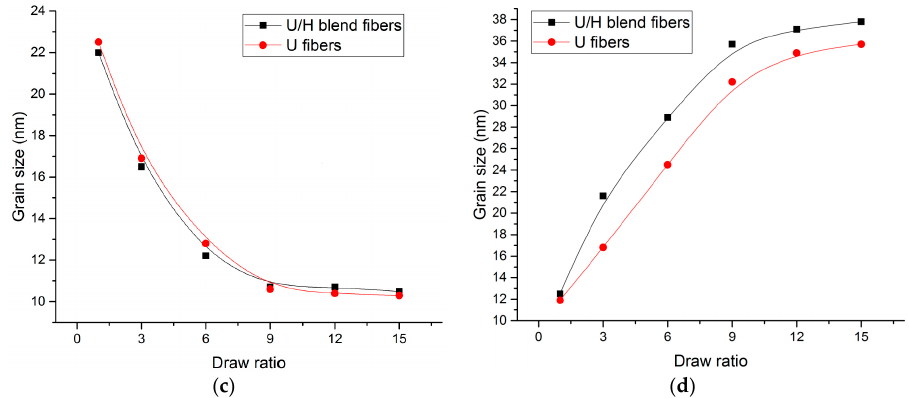
Figure 11. The grain size of the fiber samples: ( a ) (110) plane; ( b ) (200) plane; ( c ) (020) plane; and ( d ) (002) plane.